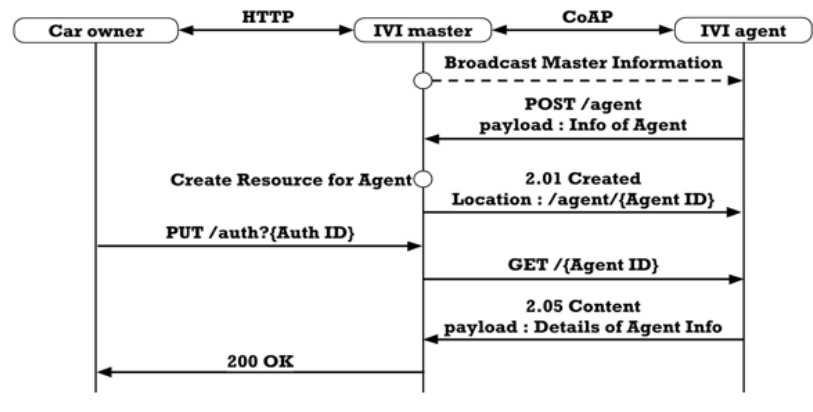
Figure 10. Operation flows for IVI agent registration .